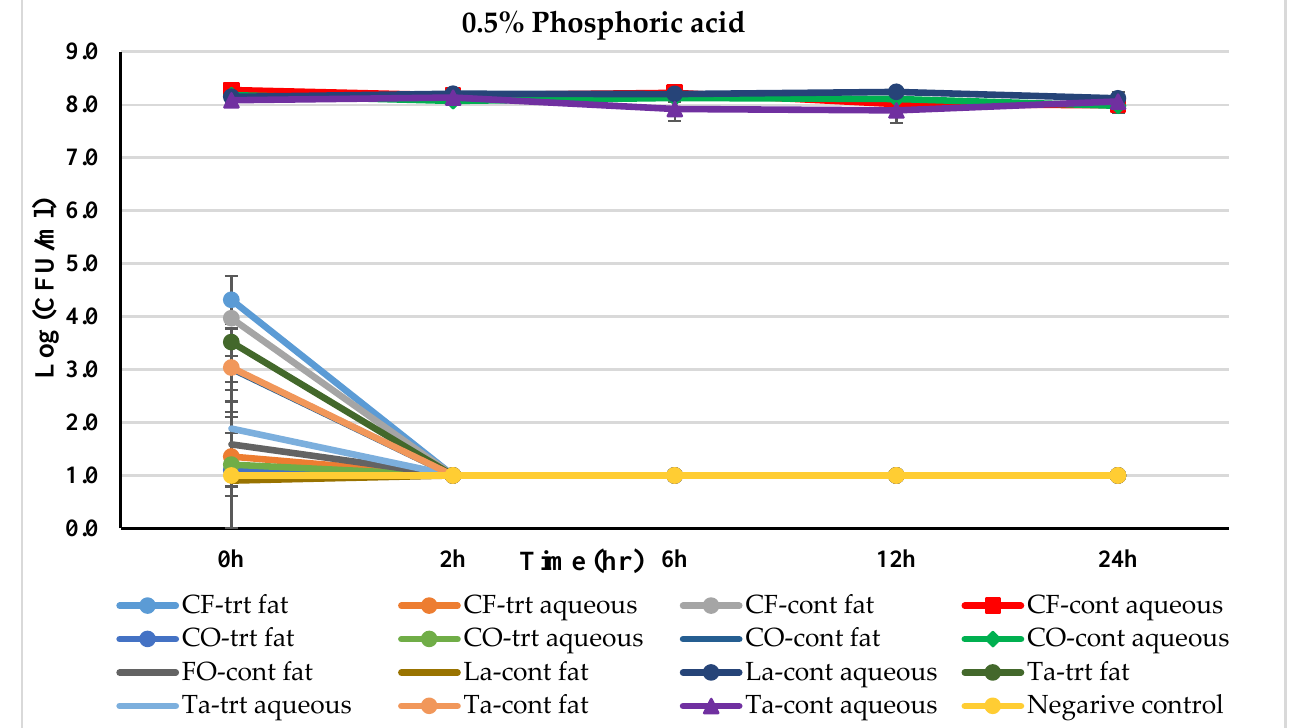
Figure 2. Mean logarithmic counts (log CFU/mL) of Salmonella spp. in different fat and oil systems with and without the inclusion of 0.5% phosphoric acid evaluated separately for the aqueous phase and fat phase at 45 °C. Treatments from each phase were plated on TSA at different times. SBS, sodium bisulfate; CF, chicken fat; CO, canola oil; FO, fish oil; La, Lard; Ta, Tallow; Cont., control. Negative control consisted of fat-oil system without acidulant and Salmonella inoculation. The limit of detection is 1 log CFU/mL for this study. Because the three replications were averaged, for some of the treatments, the counts on 0 h appeared to be lower-than-detection limit. Error bars are ± 1 standard error of the mean.